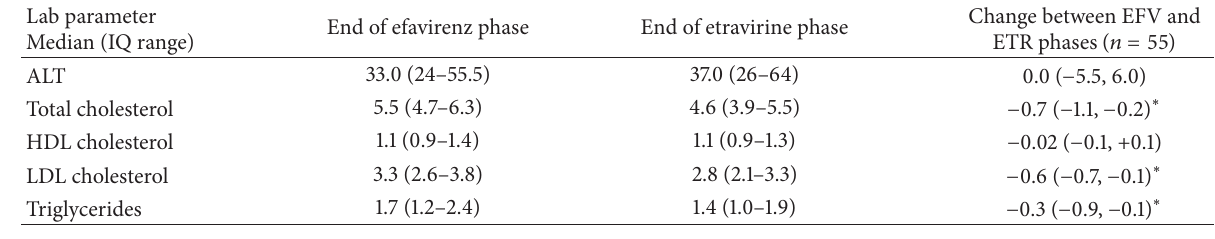
(b) ETRA-SWITCH trial: changes in lipids from baseline, to Week 24 (mmol/L) Mean lipid levels (95%